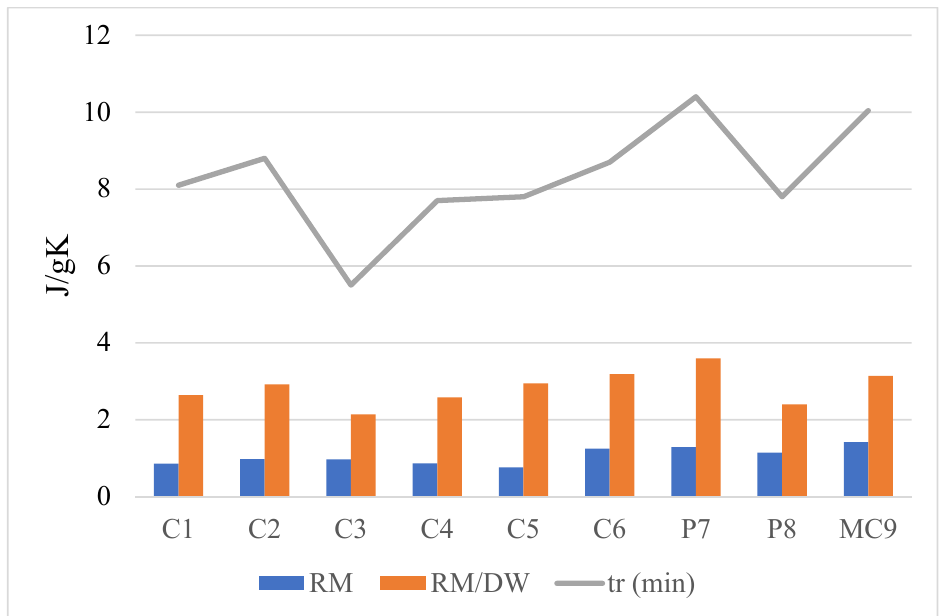
Figure 3. Specific heats of the raw materials (RMs), and specific heats and relaxation times of the raw material–distilled water (RM/DW) formulations.